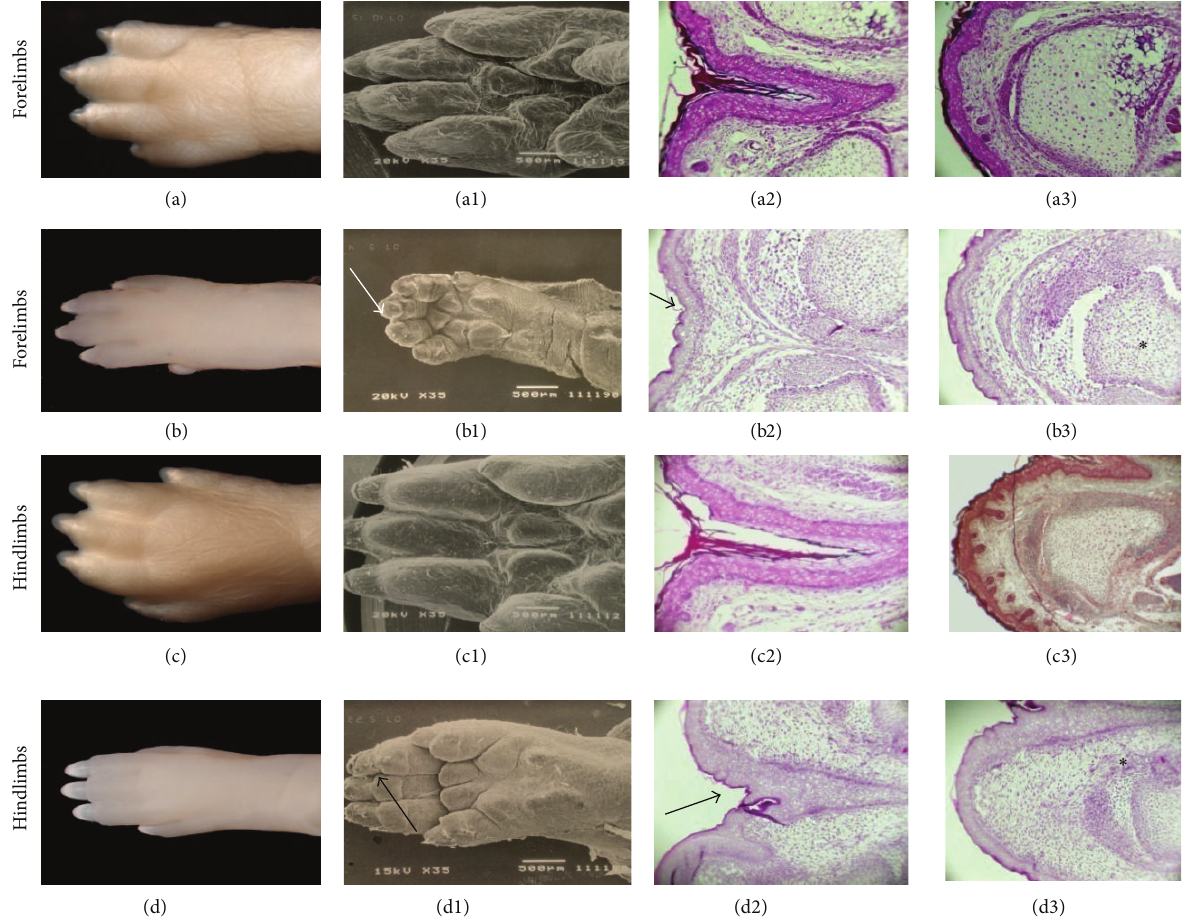
Figure 4: The morphohistology of the palmar and plantar surfaces of the limbs of F21 obtained from control rats ((a), (c)) and diabetic rats ((b), (d)). Note the minimal digit separation in F21 of DR (arrows in (b1), (b2), (d1), and (d2)) and the less advanced ossification process ( ∗ in (b3),